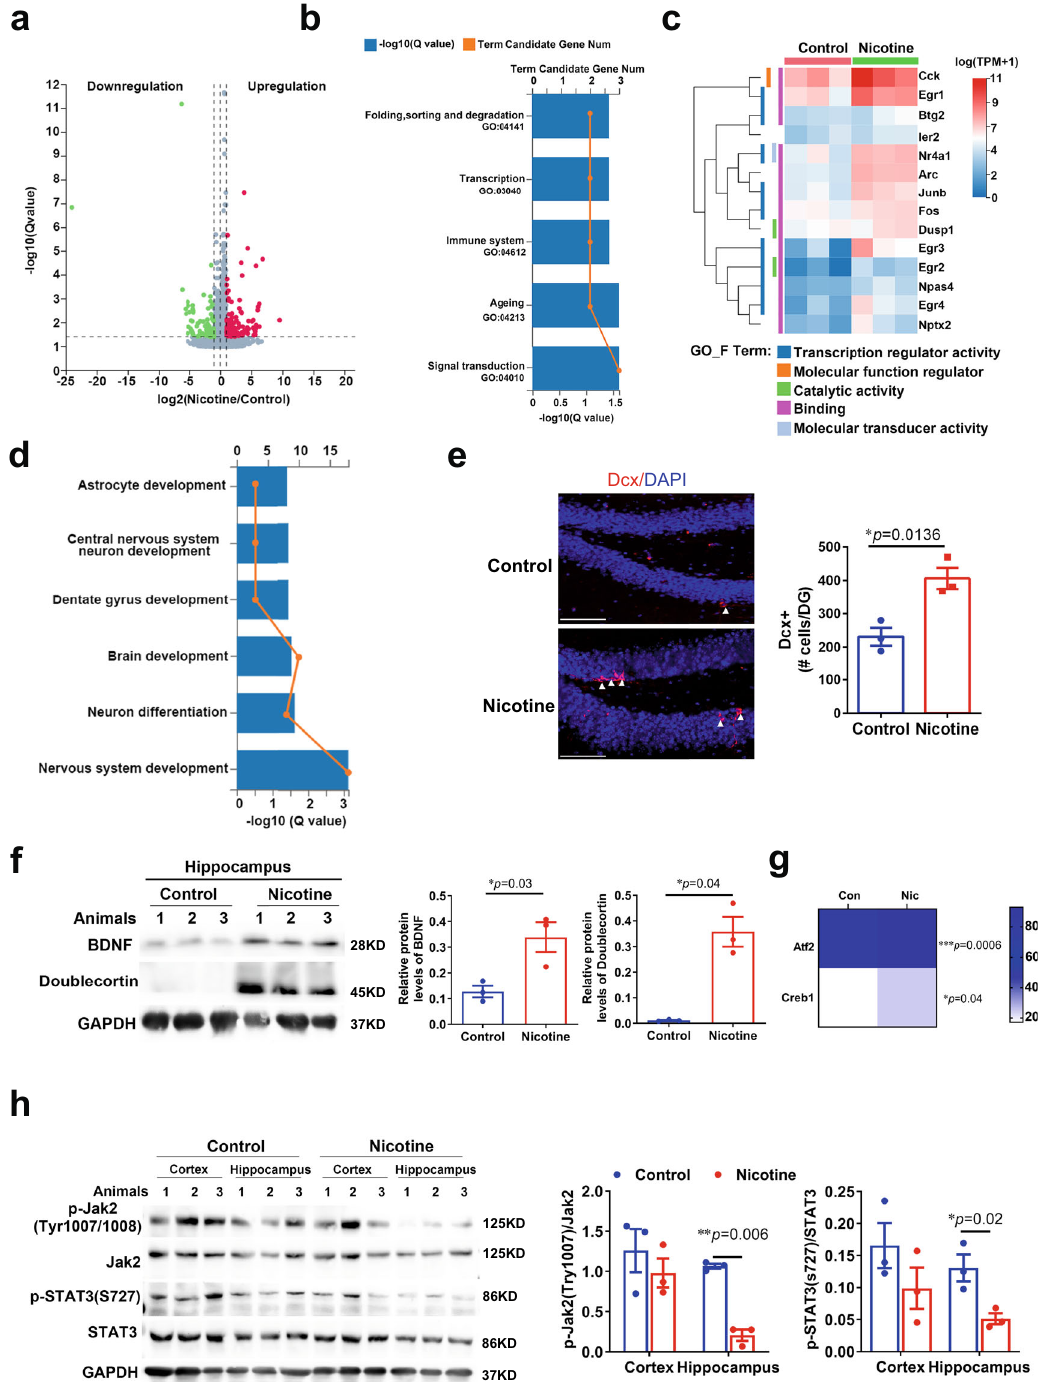
Fig. 8 | Nicotine alteredgene Expression ofthe aged mice brain and promoted neurogenesis and inhibited in fl ammation. a Volcano plots of differentially expressed genes ( n =3, biologically independent samples/group). b The Gene KEGG pathways related to “ Signal transduction ” , “ Ageing ” , “ Immune system ” , “ Transcription ” between control mice and nicotine mice after nicotine admini- strated for 6 months ( n =3, biologically independent samples/group). c Heatmap depicting transcriptional pro fi les of KDA gene and Go function enrichment ( n =3, biologically independent samples/group). d The “ GO_biological processes ” were related to neurogenesis: nervous system development, neuron differentia- tion, brain development, dentate gyrus development, central nervous system neuron development ( n =3, biologically independent samples/group). e Representative microscopic fi elds and quanti fi cation of Dcx-positive cells in the dentate gyrus (DG) of the hippocampus of naïve aged mice administered with or